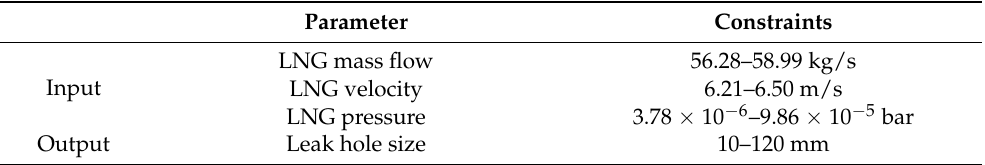
Table 1. Input and output data (hole size prediction